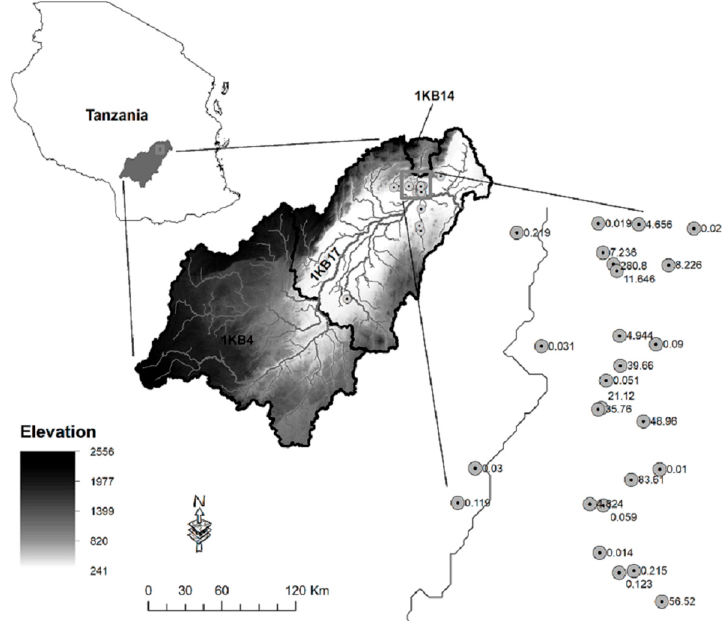
Figure 1. Site map showing Kilombero Valley River basin located in central Tanzania and three catchments (1KB17, 1KB14 and 1KB4) used in this study (with the overall watershed outlet located in catchment 1KB17). Streams are indicated as gray lines. Pumping wells are indicated as gray circles with black dots at the centers. The map at far right shows zoomed in locations of boreholes and stream pattern in the Kilombero Valley River basin. The number shown at the right of each borehole is the transmissivity (m 2 /min).